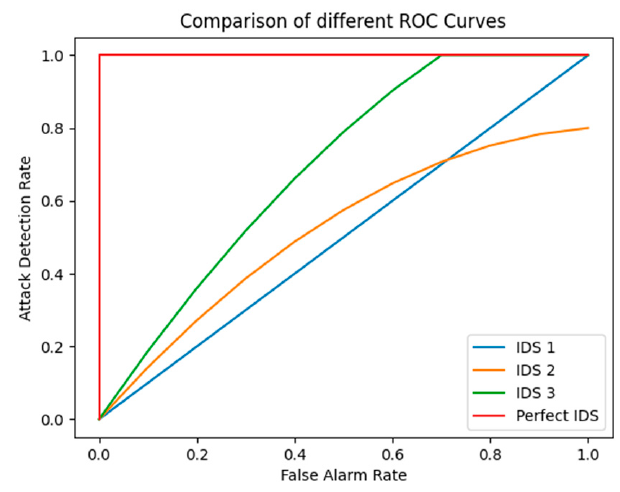
Figure 1. ROC Curves for different IDSs.